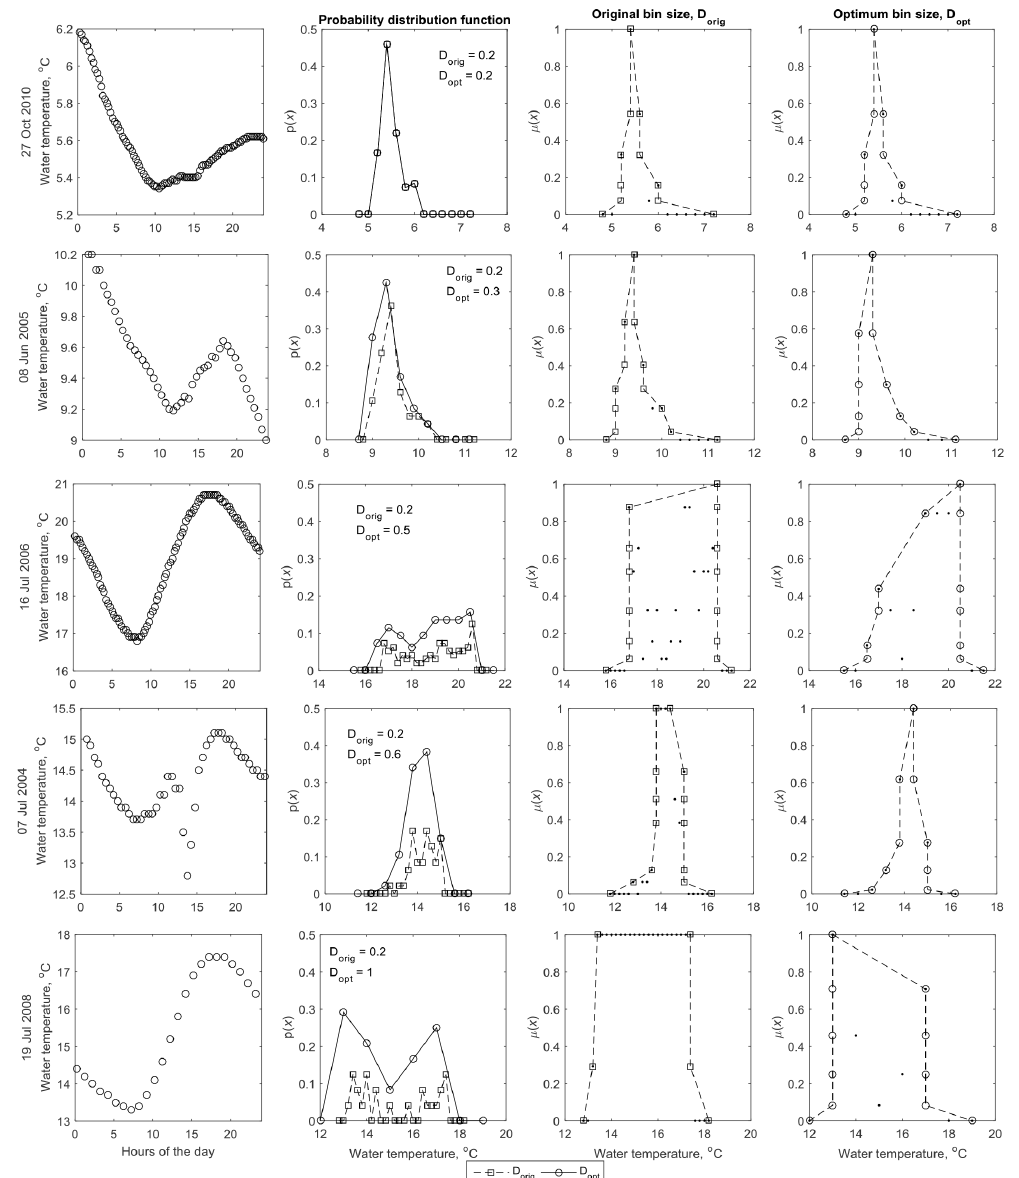
Figure 4. Sample results of probability–possibility transformation for water temperature, T